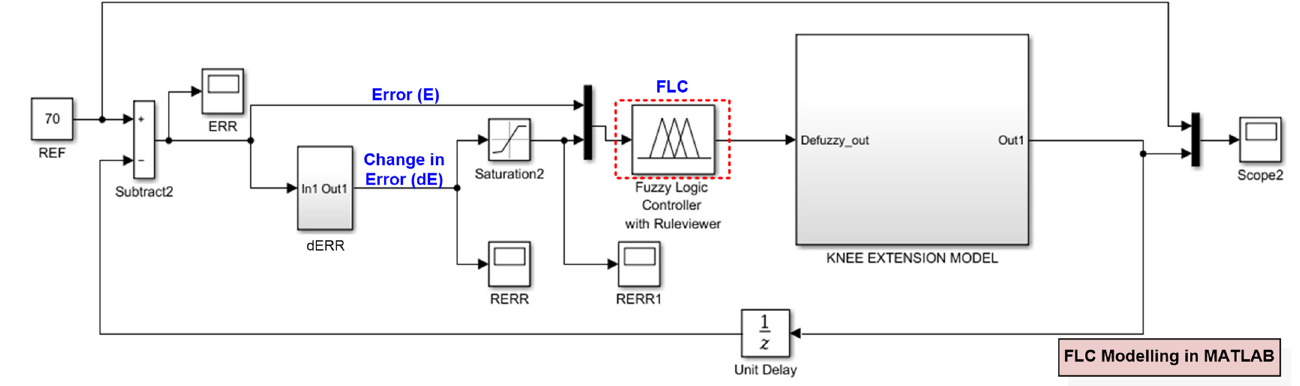
Figure 4. FLC modelling using the knee extension model as a plant in MATLAB Simulink.